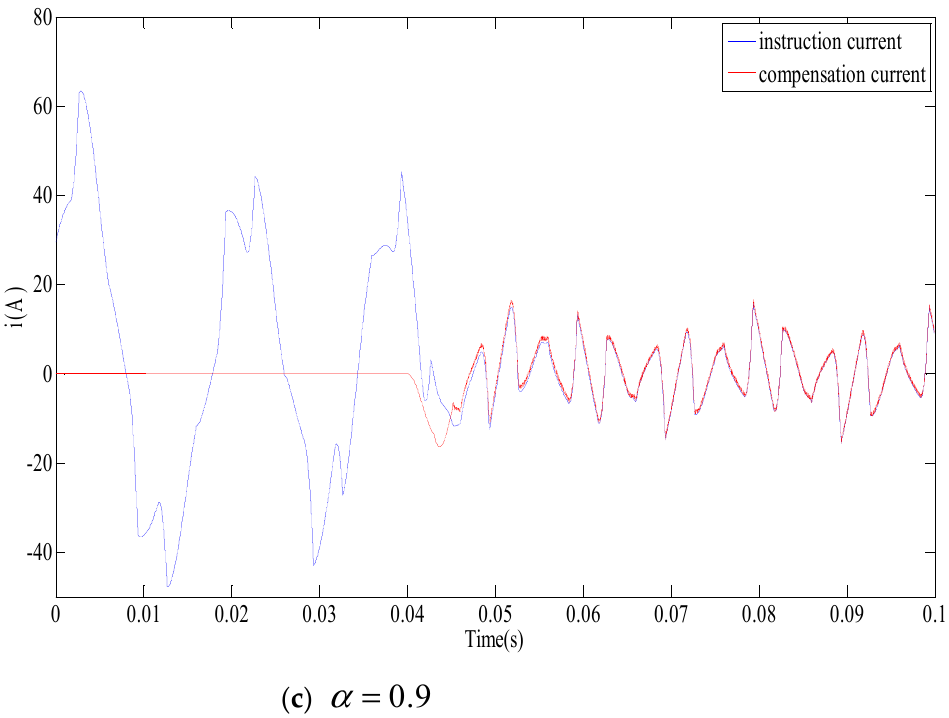
Figure 5. Instruction current and compensation current with different values of the fractional order.